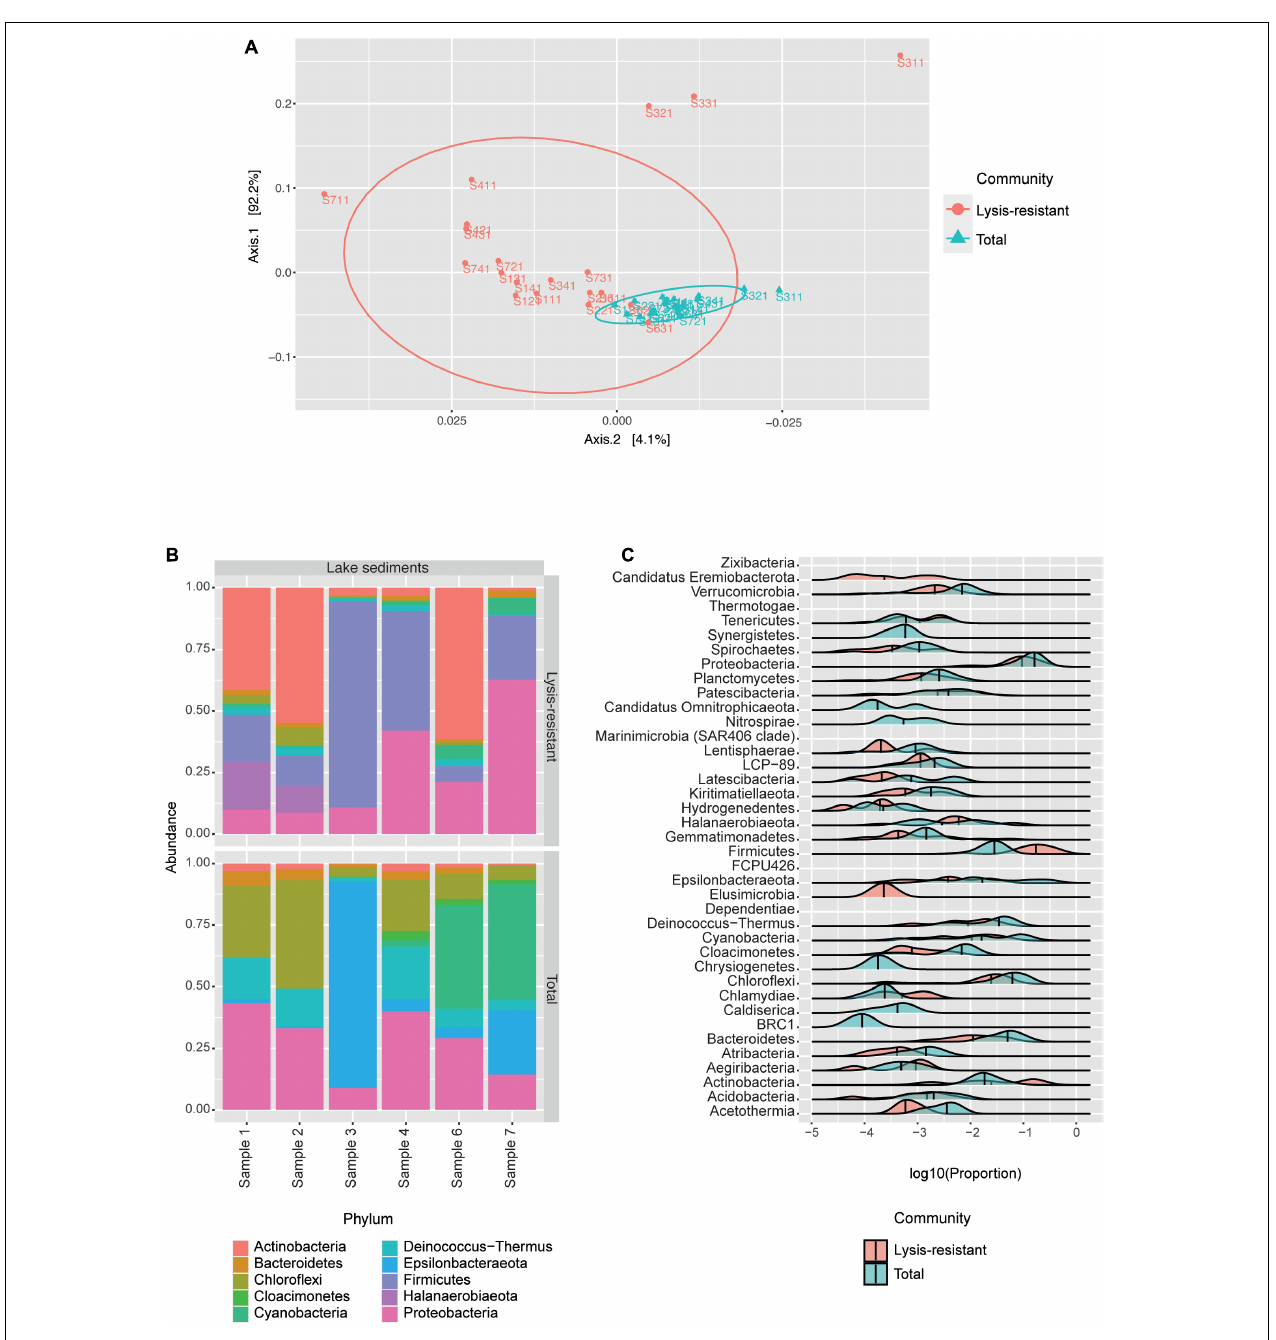
FIGURE 3 | The bacterial community in the lake sediments. (A) Weighted UniFrac PCoA of the bacterial community, belonging to the lysis-resistant fraction (red) or the total fraction (blue). The ellipses show a 95% confidence level per group. (B) Top 50 bacterial ASVs relative abundance per lake sediment core at the phylum level. (C) This plot shows the abundance distribution of the different phyla, for either the lysis-resistant (red) and the total fraction (blue) in the lake sediments, the abundance is shown in log10 of the relative abundance.